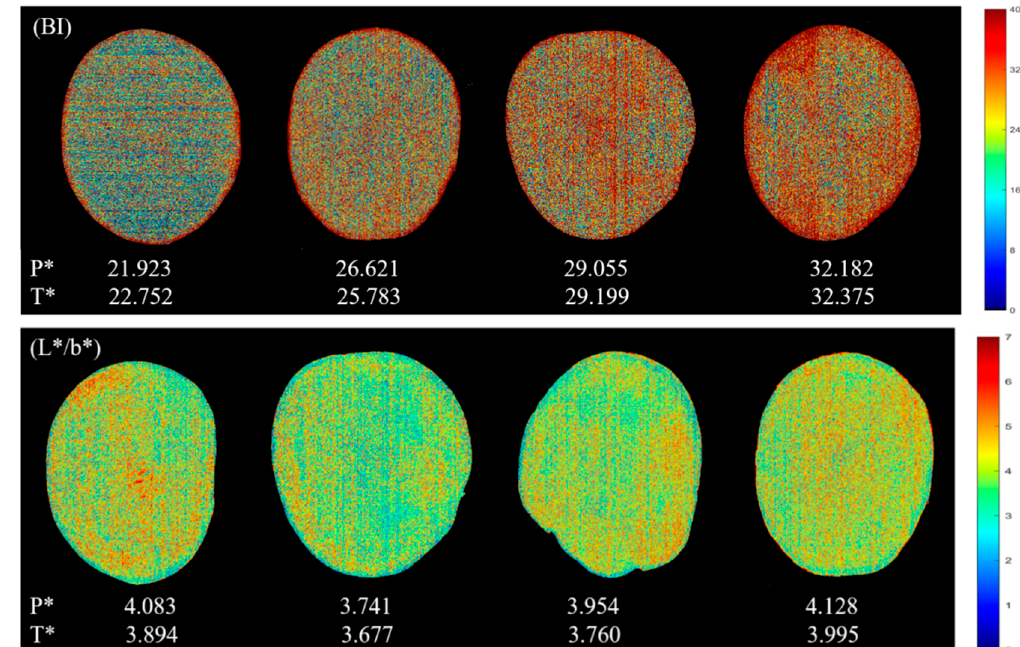
Figure 2. Pixel-wise prediction maps developed on the CARS-LS-SVM models for color visualization (P* is the predicted average value of all pixels; T* is the actual value measured by the chromatic aberration method).